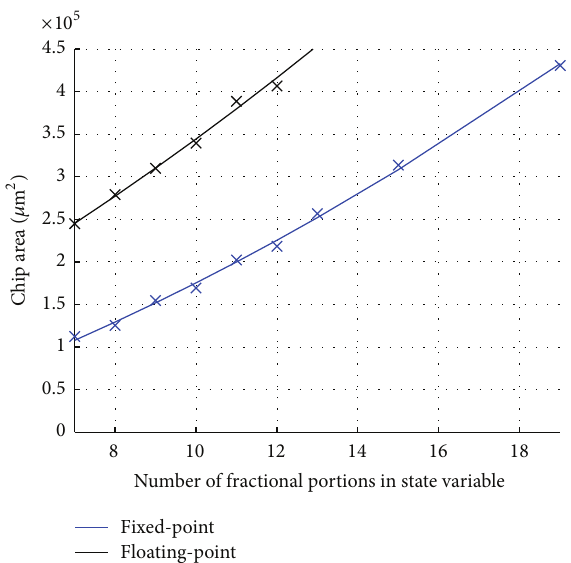
Figure 4: Chip area for programmable coefficients of the IIR filter with three biquadratic filter stages for fixed- and